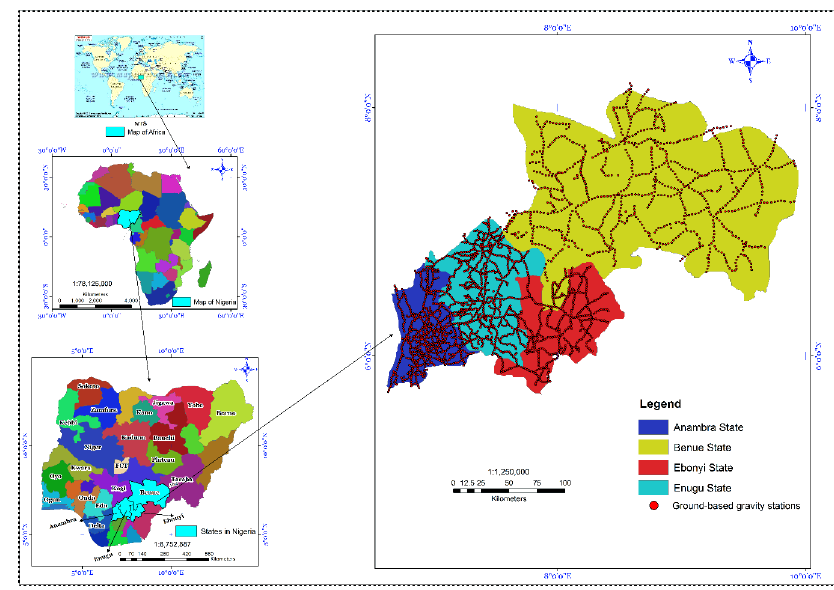
Figure 1. Ground-based gravity stations within the study